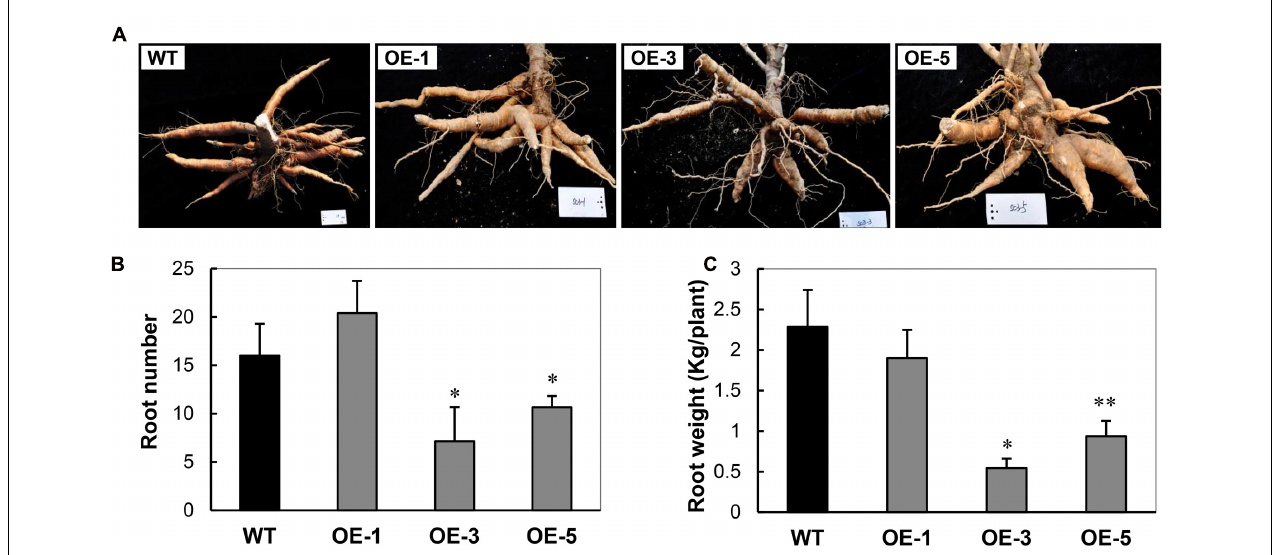
FIGURE 2 | Characteristics of storage roots harvested from the field-grown wild-type (WT) and transgenic (OE) lines. (A) Storage root phenotypes. (B) Storage root number per plant. (C) Storage root weight per plant. Data are presented as mean ± SD of three independent assays; asterisks indicate significant differences compared with the WT, ∗ P < 0.05 or ∗∗ P < 0.01 by Student’s t -test.